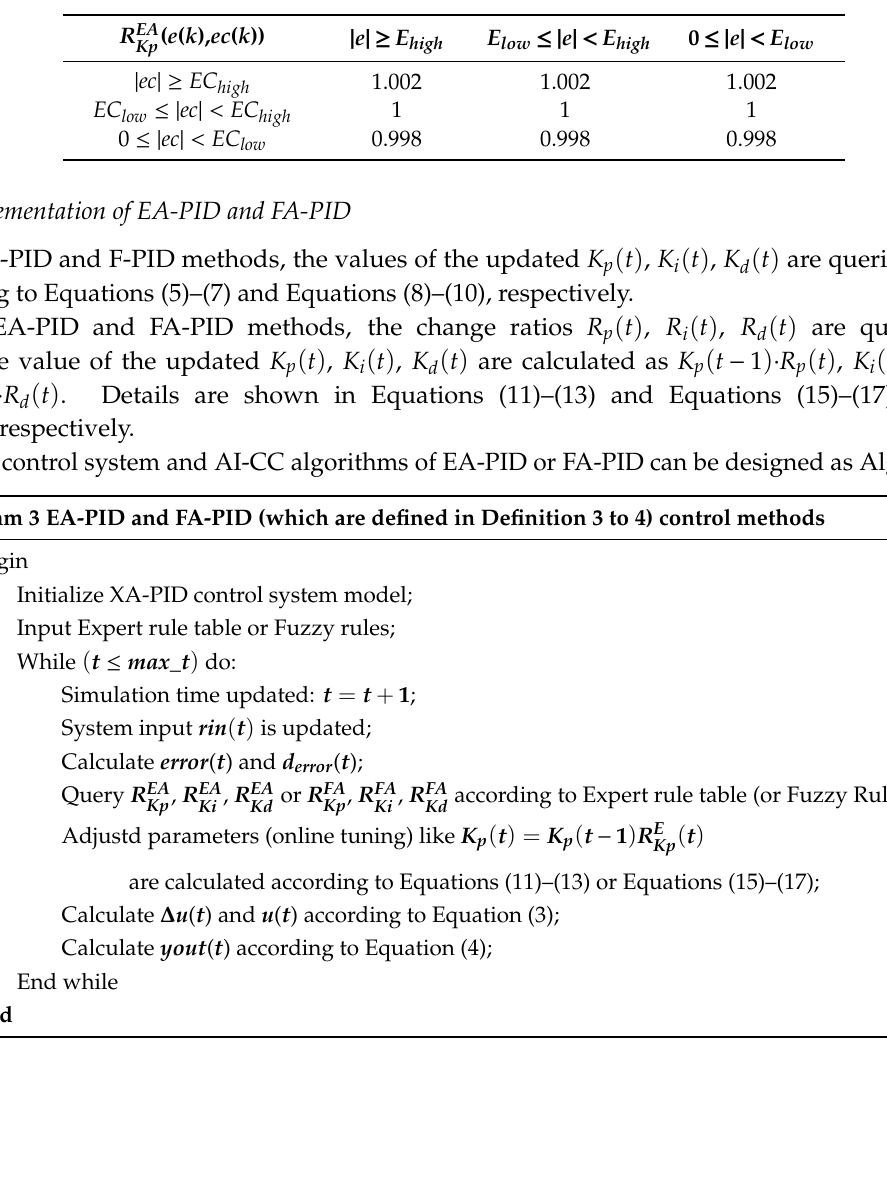
Table 4. Expert rule table of EA-PID for parameter K d